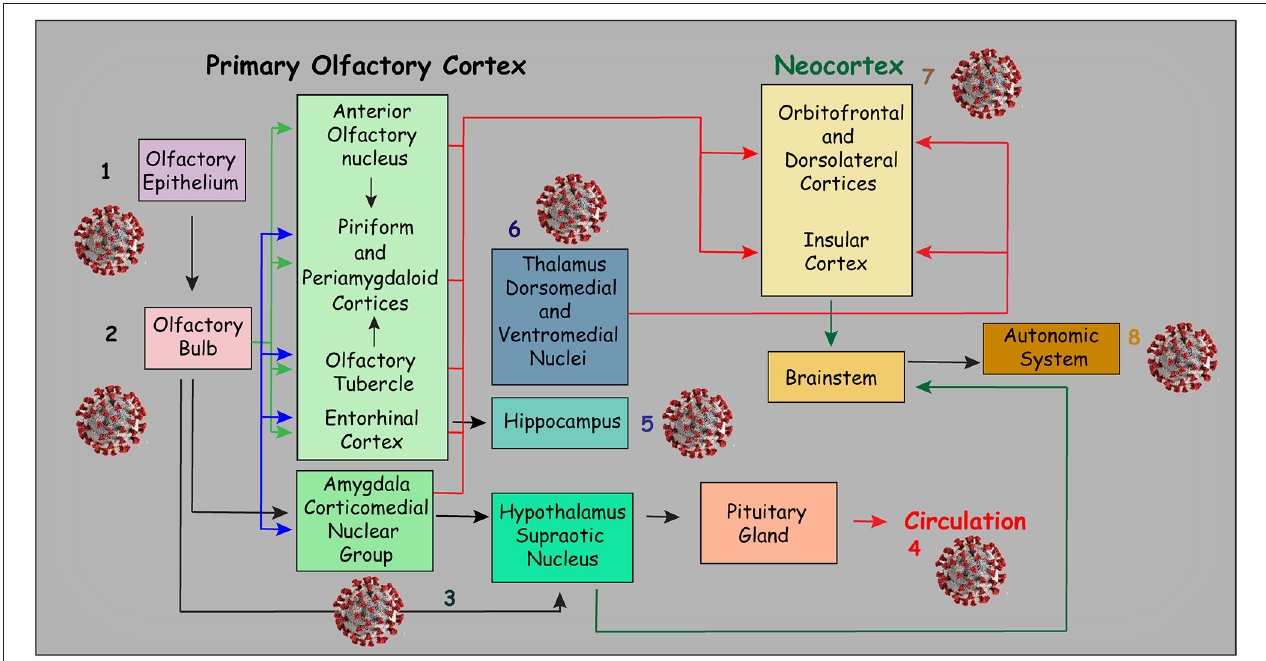
FIGURE 2 | Diagram illustrating the main connections of the primary olfactory cortex. Viral sketches represent the possible symptoms related to the area of impairment: Loss of smell is probably the most evident symptom (1 and 2). However, through direct and indirect connections, the olfactory pathway may be related to several neurologic symptoms. For instance, the connections of the olfactory pathway with the amygdala nuclei may be related to emotional impairment. In addition, other central nervous system changes and neurologic symptoms that may be related to direct or indirect connections of the olfactory pathway are illustrated in this figure. For example, indirect connections to some hypothalamic nuclei, especially the supraoptic nucleus (3) may affect neuroendocrine control, which may, in turn, affect the function of the pituitary gland (4). Moreover, connections to the hippocampus (5) may result in memory impairment. On the other hand, indirect connections to some thalamic nuclei may be associated with sensory and movement impairment (6) while the connections to the frontal and insular cortices (7) may be associated with cognitive impairment. Indirect connections with the brainstem may also result in autonomic nervous system impairment (8). Not surprisingly, the ACE receptor has been found in several of the areas illustrated in this figure ( Chen R. et al., 2020). This figure has been adapted from a previous work Devere